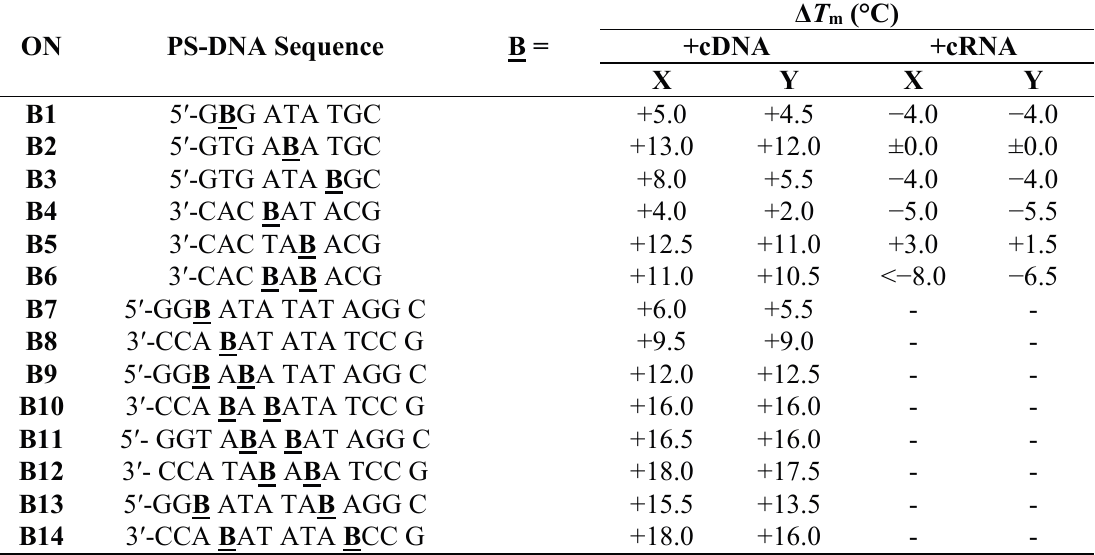
Table 1. Change in thermal denaturation temperature ( Δ T m ) of duplexes between X- / Y -modified PS-DNA B1 – B14 and cDNA/cRNA, relative to duplexes between reference PS-DNA and cDNA/cRNA a